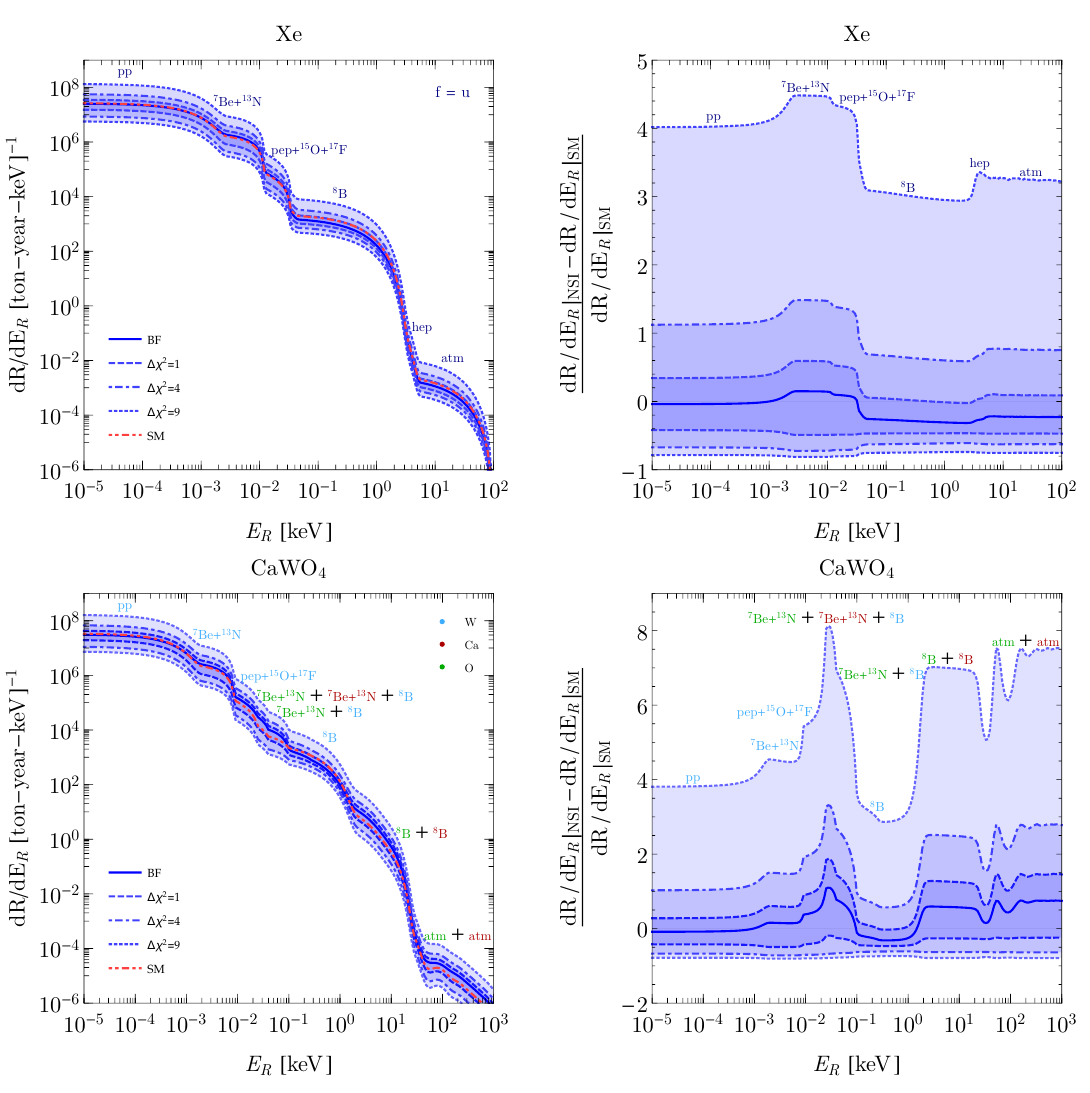
Figure 2 . Expected di(cid:11)erential recoil event rate (left) and the fraction of the NSI contribution compared to the SM one (right) as a function of the recoil energy E R for the solar and atmospheric neutrino (cid:13)uxes. In the upper (lower) panels the detector target is Xe (CaWO 4 ). The full line corresponds to the prediction for the best (cid:12)t NC-NSI and oscillation parameters of the analysis of oscillation+COHERENT data, and the shaded regions bordered by dashed, dot-dashed, and dotted lines correspond to predictions with NSI and oscillation parameters with (cid:1) (cid:31) 2 4, 9,